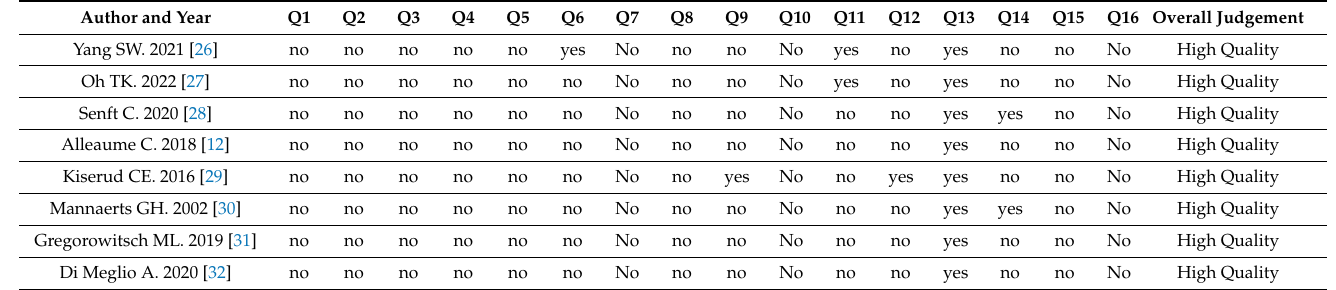
Table 2. RTI quality assessment of included studies. Y: Yes (affirmative answer). N: No (negative